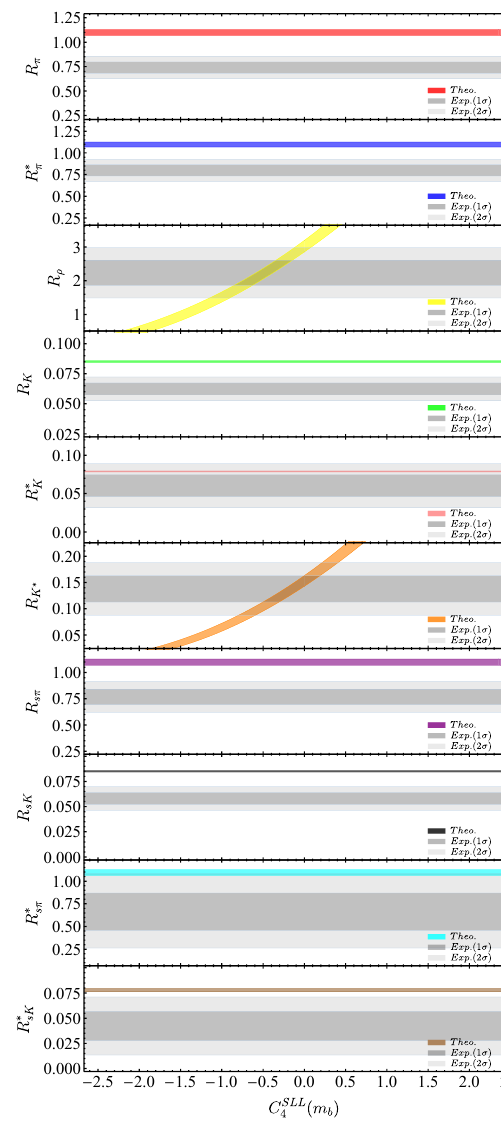
( m b ) (left) and C SLL